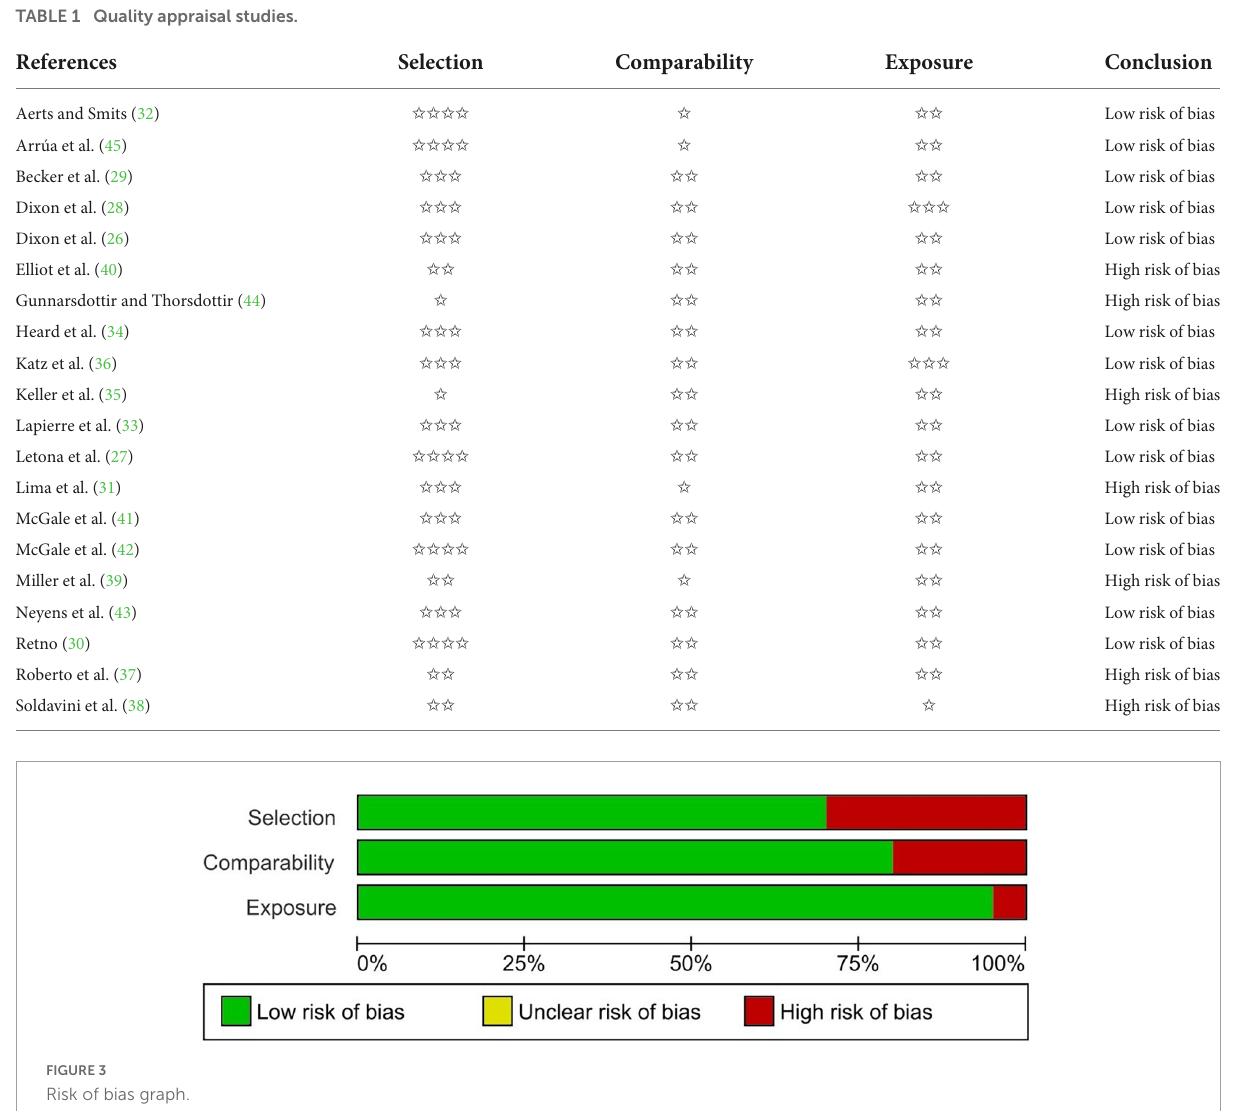
TABLE 1 Quality appraisal studies.